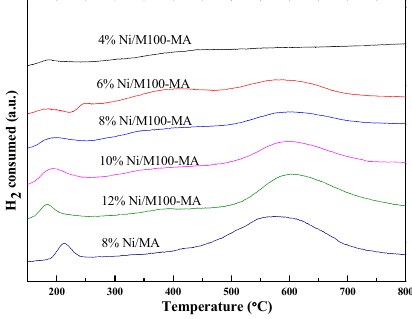
Figure 11. TPH profiles of the spent catalysts.